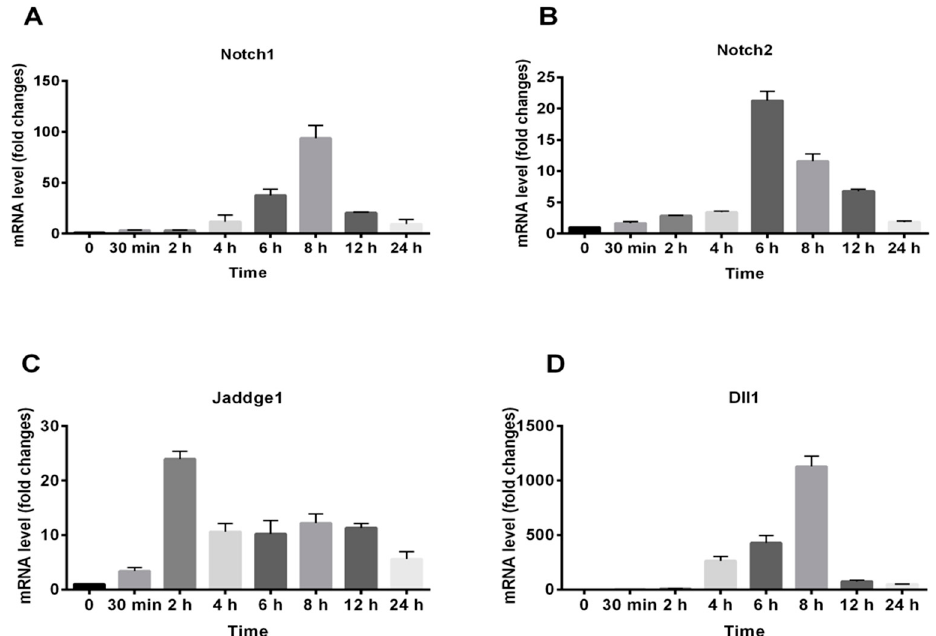
Figure 6. Gene expression profiles of Notch1, Notch2, Jaddge 1, and Dll1 in RAP-activated RAW264.7 macrophage cell lines. RAW264.7 cells were treated with RAP (100 µ g / mL) with di ff erent time. The total RNA was isolated at indicated times. Expressions of Notch1 ( A ), Notch 2 ( B ), Jaddge 1 ( C ), and Dll1 ( D ) were analyzed by qRT-PCR.